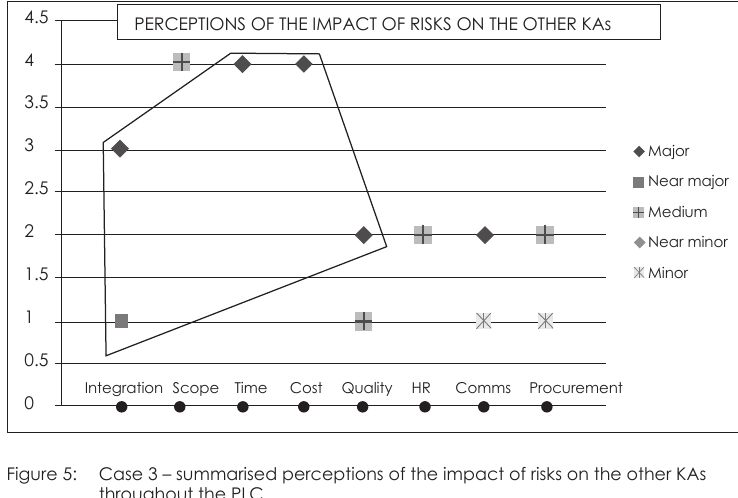
Figure 5: Case 3 – summarised perceptions of the impact of risks on the other KAs throughout the PLC